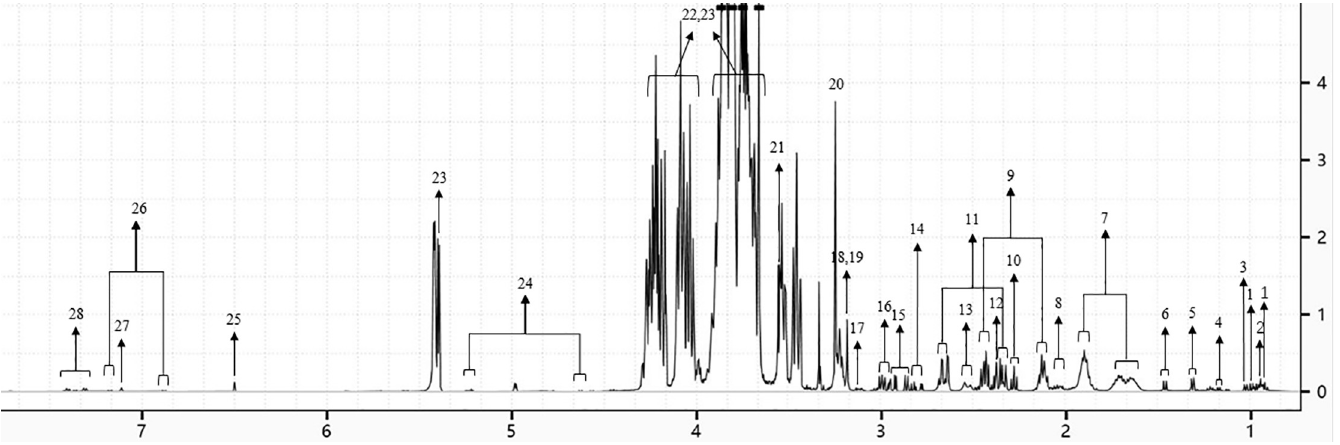
Fig 2. A representative 1 H-NMR spectrum of the metabolites identified in Jerusalem artichoke tubers. (1) isoleucine, (2) leucine, (3) valine, (4) ethanol, (5) threonine, (6) alanine, (7) arginine, (8) glutamate, (9) glutamine, (10) 4-aminobutyrate, (11) malate, (12) succinate, (13) citrate, (14) aspartate, (15) asparagine, (16) 2-oxoglutarate, (17) malonate, (18) choline, (19) O-phosphocholine, (20) betaine, (21) glycine, (22) fructose, (23) sucrose, (24) glucose, (25) fumarate, (26) tyrosine, (27) histidine, (28) phenylalanine.